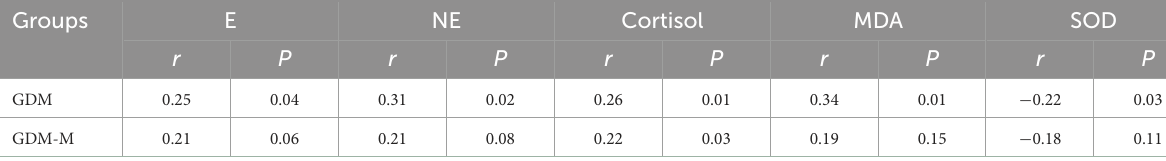
TABLE 2 Correlation of stress hormones and oxidative stress with HOMA-IR.